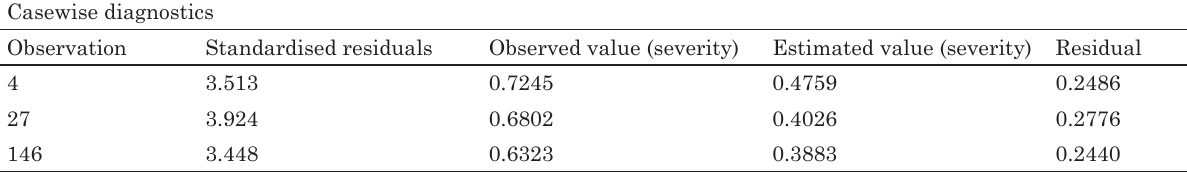
Table 6. Durbin-Watson critical values for the proposed model